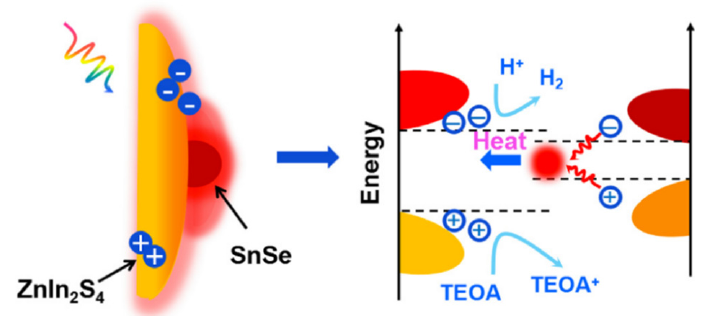
Figure 3. Schematic illustration of the photocatalytic H 2 generation process over SnSe/ZnIn 2 S 4 (Reprinted/adapted with permission from Ref. [31]. Copyright 2021, copyright Elsevier).